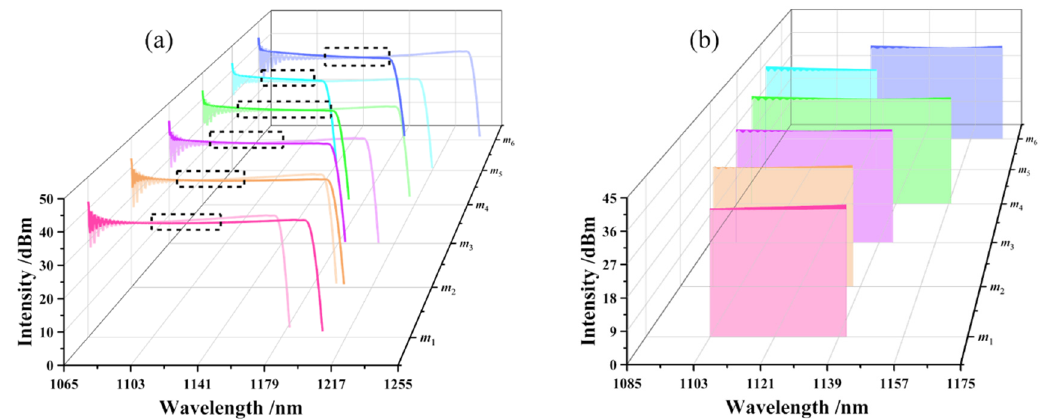
Figure 3. Spectral distribution of DOFC with different cascading order m , cascading order m 1 = 50, m 2 = 100, m 3 = 150, m 4 = 200, m 5 = 250, L = 6 cm, N = 200, I 0 = 100 MW/cm 2 , I 1 = 1 MW/cm 2 , I 2 = 1 MW/cm 2 . ( a ) Spectral distribution of DOFC with different cascading order m ; the range covered by the dashed box was DOFC within 1 dB flatness. ( b ) Enlargement of the dashed box in ( a ). Equations (1) and (2) show that phase mismatches Δ k a/b, m affected the interaction of cascaded Stokes waves. The interaction length of the m th-order CDFG was Δ L m , and Δ L m = L / m . By changing the crystal length L and keeping cascading order m constant, the vari- able Δ L m changed the transfer speed of the cascaded Stokes waves to high-order Stokes waves. Figure 4a shows the spectral distribution of DOFC with different crystal lengths L . The DOFC spectrum range of 271–280.1 THz was extremely narrow for L 1 = 4 cm. As the crystal length L increased from 4 cm to 4.5 cm, 5 cm, 5.5 cm, and 6 cm, the DOFC spectral